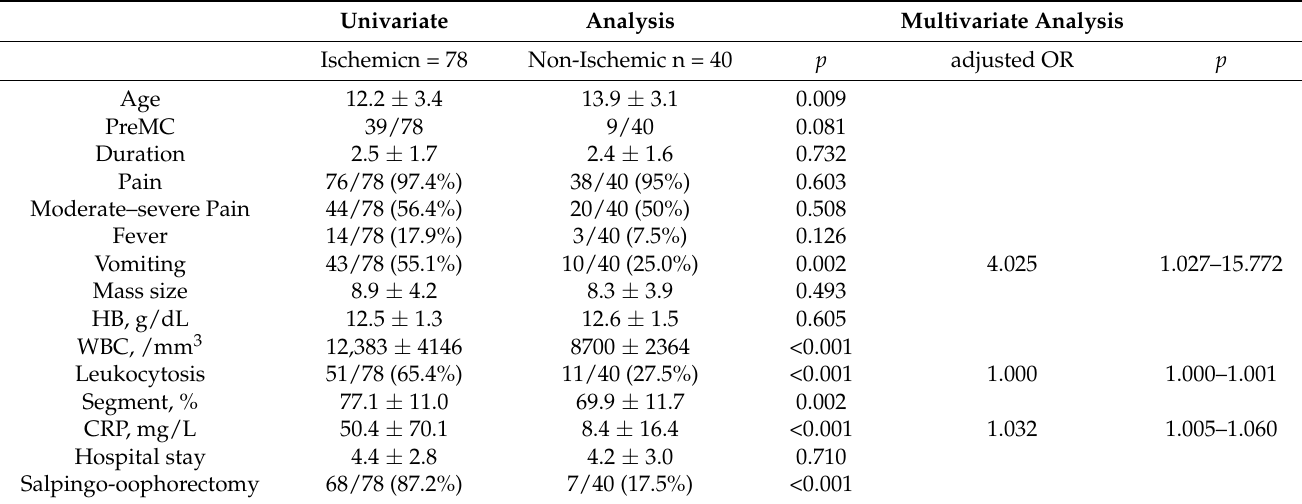
Table 2. Univariate and multivariate analyses between ischemic and non-ischemic ovary torsion. Univariate Analysis Multivariate Analysis Ischemicn = 78 Non-Ischemic n = 40 p adjusted OR p